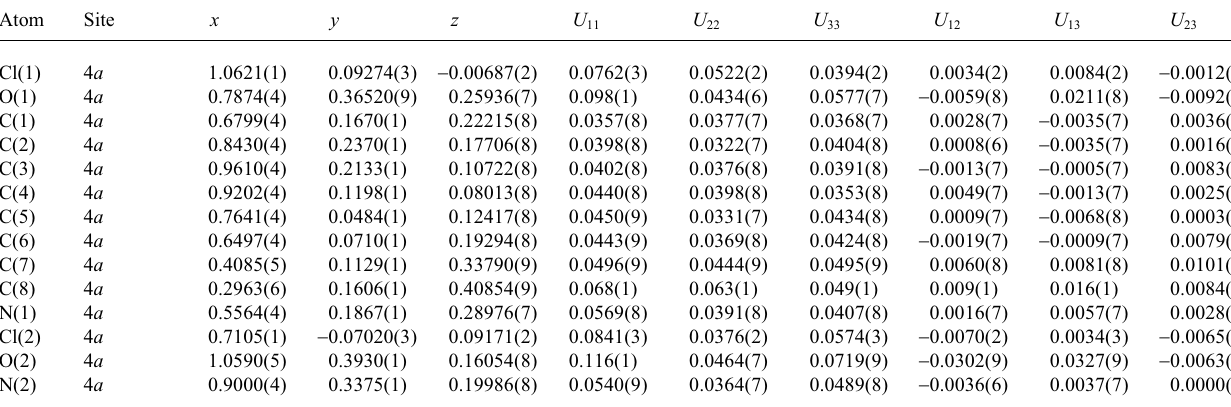
Table 3. Atomic coordinates and displacement parameters (in Å 2 )